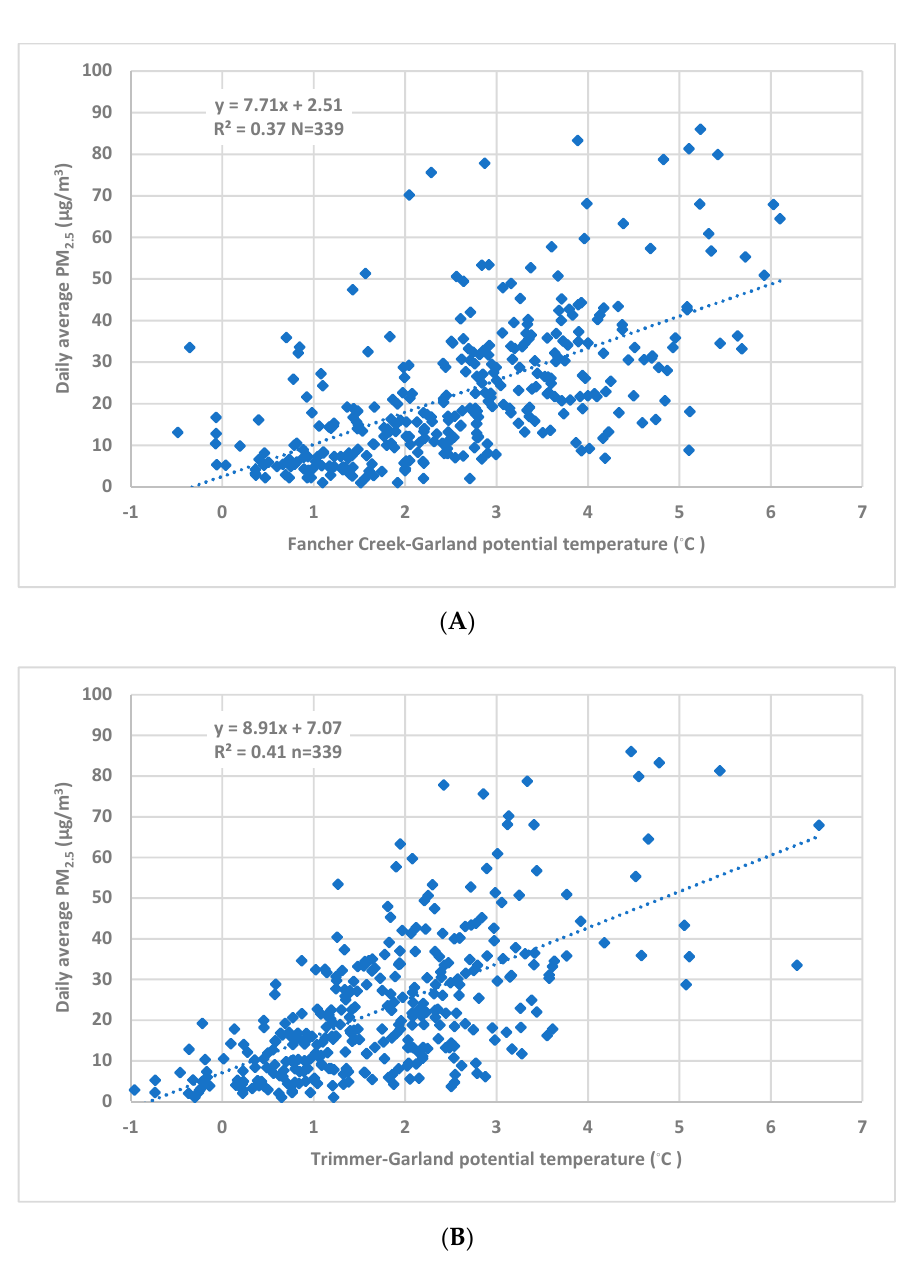
Figure 7. The relationship between the daily average PM 2.5 and the potential temperature difference